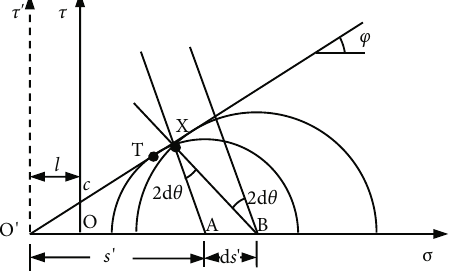
Figure 10: Deviation diagram of stress circle centers.